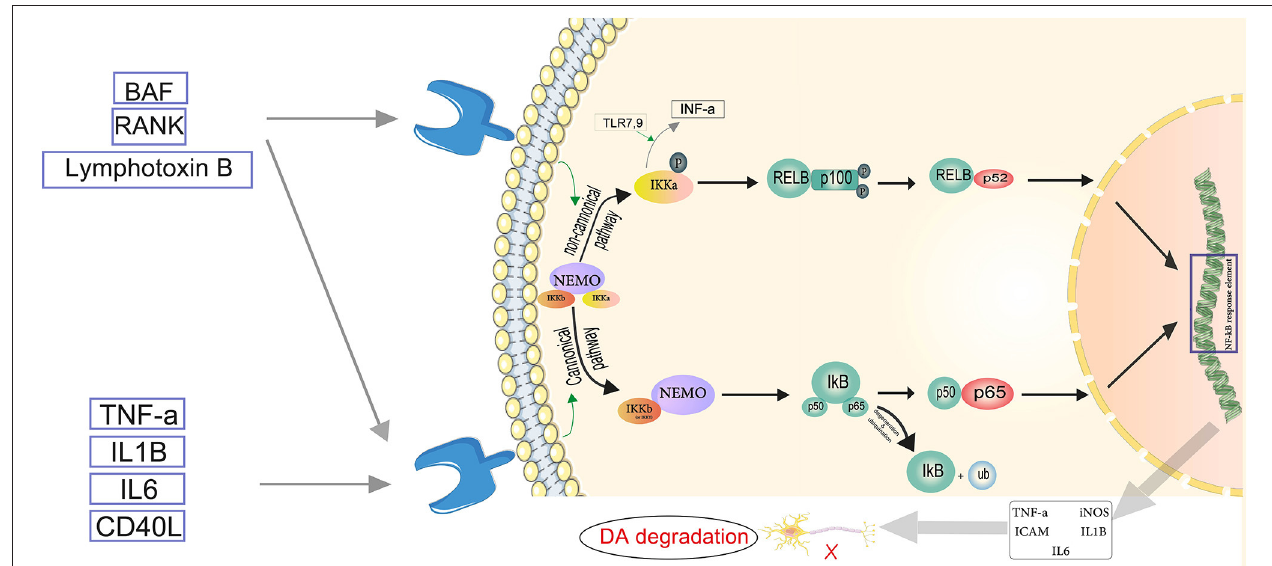
FIGURE 3 | Servier (2022) the neuroinflammatory cascade mediated by NF- κ B. TNF- α , IL-1 β , IL-6, and CD-40L are proinflammatory substances activating the canonical pathway. In the canonical pathway, an inhibitor of κβ kinase (IKK) β (or IKK γ ) is required for NF- κ B activation. IKK β phosphorylates I κβ . The regulatory subunit of the IKK complex is the NF- κ B essential modulator (NEMO). In the cytosol, I κ B is degraded by proteasomes, and the phosphorylated heterodimer of NF- κ B (p50–p65) is transferred to the nucleus and binds to the NF- κ B response element. Thus, pro-inflammatory mediators such as TNF- α , IL-1 β , IL-6, iNOS, and ICAM become activated, which play role in the degradation of dopaminergic neurons (DA). In the non-canonical pathway, NEMO phosphorylates IKK- α and induces proteasomal destruction as well as proteasomal processing of p100, a subunit of the NF-B heterodimer, creating the p52-RELB active heterodimer. IK κ induces INF- α production, triggered by TLR7,9. The p52-RELB active heterodimer enters the nucleus and binds to the NF- κ B response element, regulating the expression of pro-inflammatory factors. Eventually NF- κ B mediated neuroinflammation plays role in Parkinson’s disease through DA